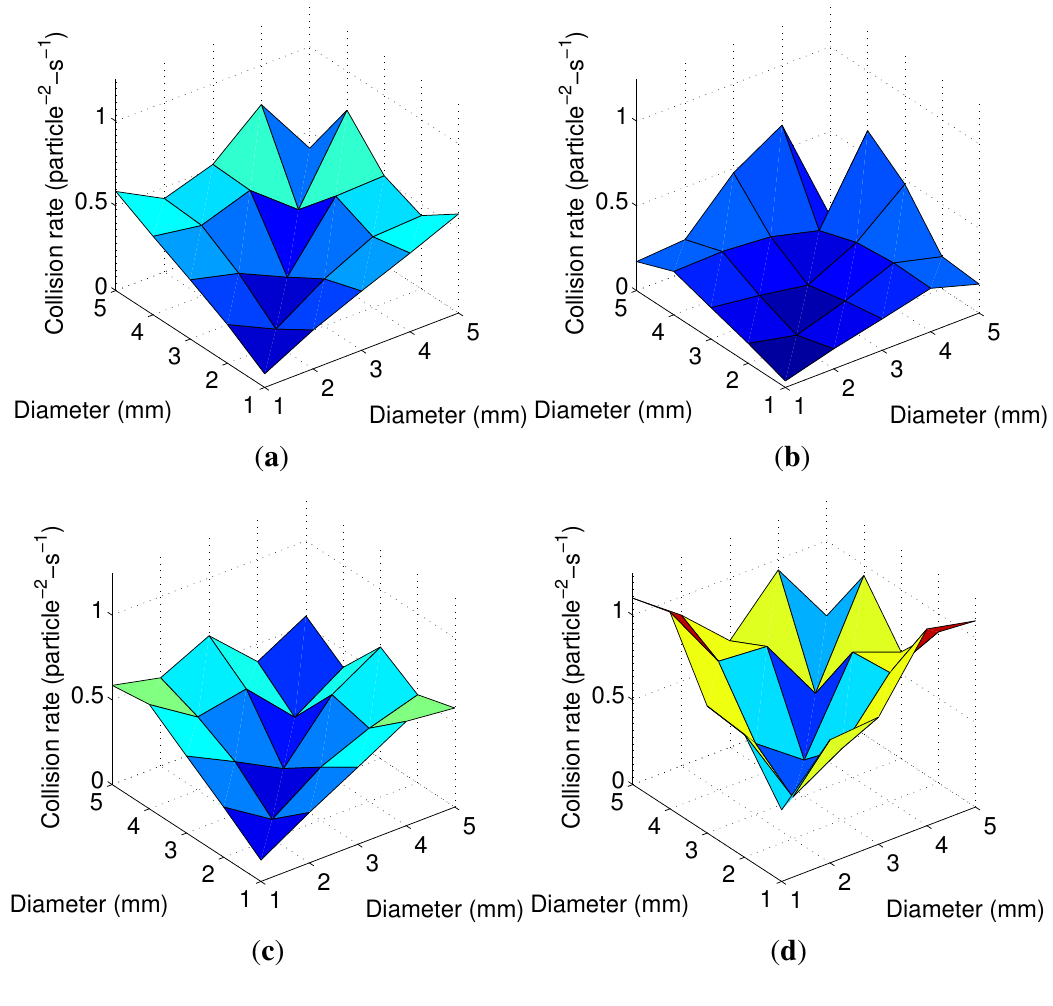
Figure A2. Collision frequency versus particle size for each distribution based on DEM simulations. ( a ) D1; ( b ) D2; ( c ) D3; ( d ) D4.